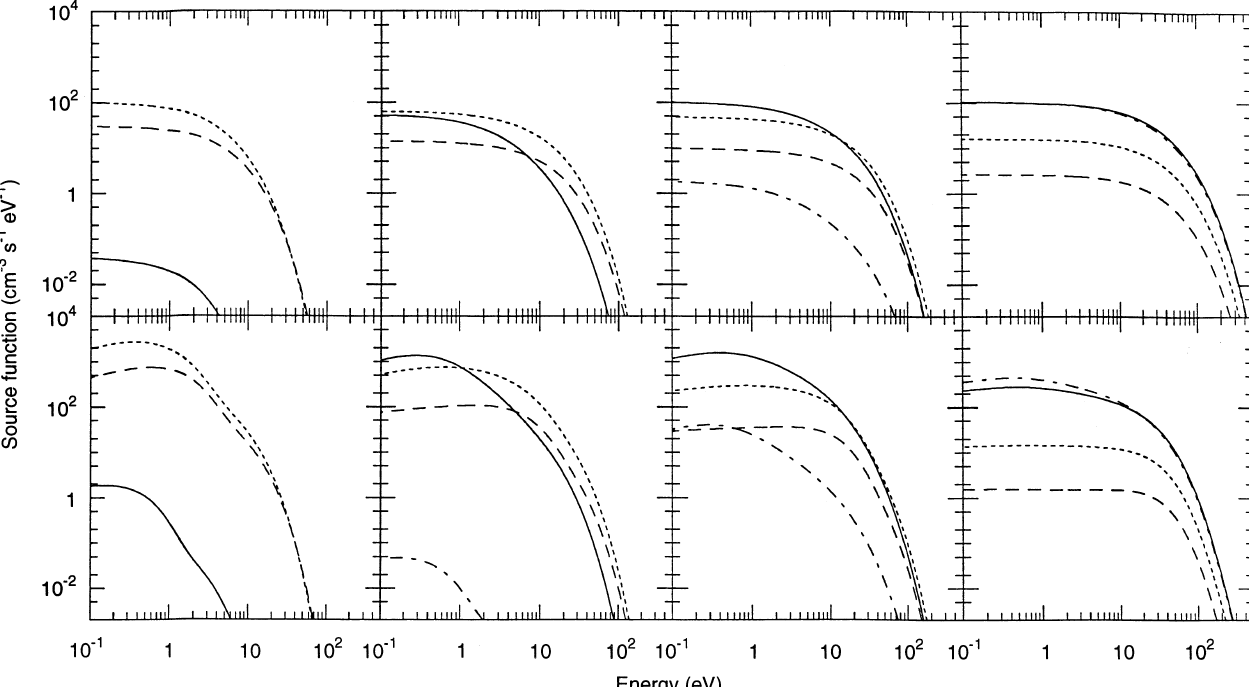
results due to the 1 keV, 5 keV, 10 keV and finally 50 keV input Maxwellian proton fluxes. The dashed lines are the source functions at 160 km height; the dotted lines , at 131 km; the solid lines at 111 km and the dash/dotted lines at 105 km